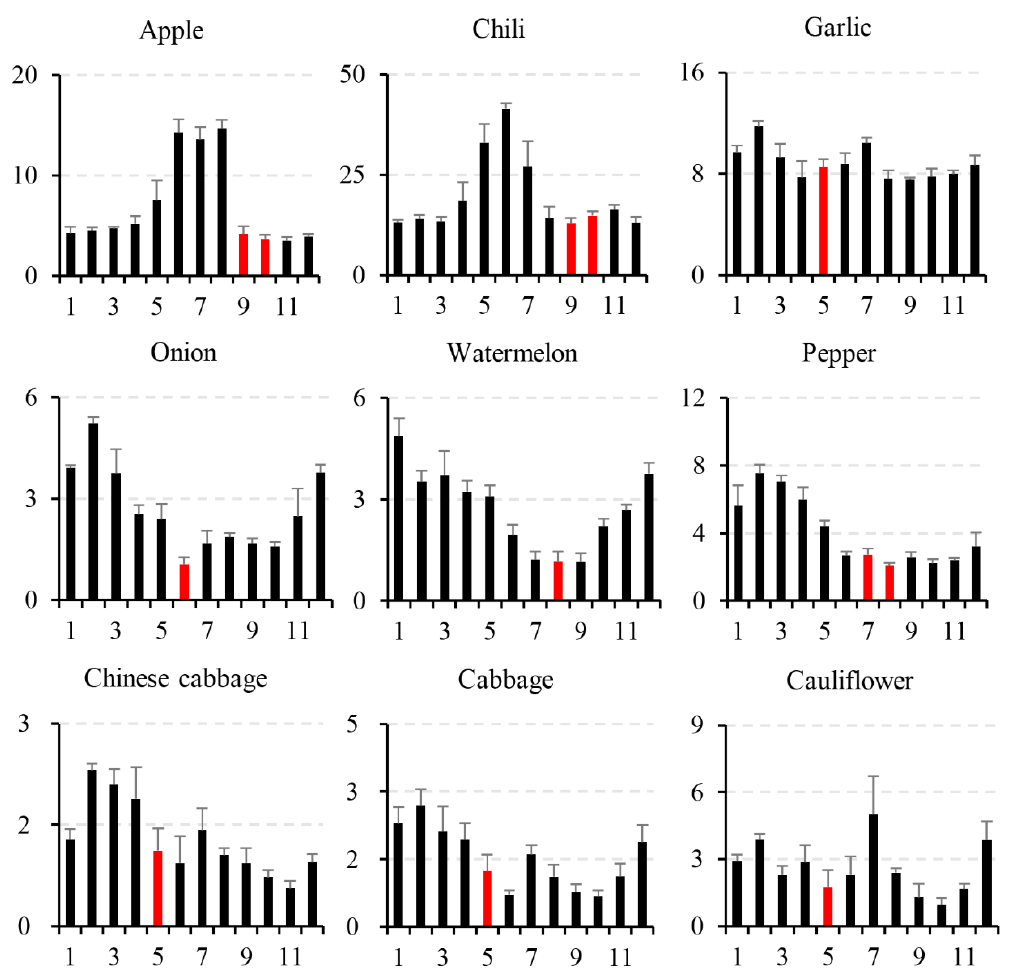
Figure 7. The price of different crops during the year in 2019. (The vertical axis is crop price, ¥/kg. The horizontal axis is the month. Bars represent the standard deviations of the prices on different days: a red bar represents the price during the selling